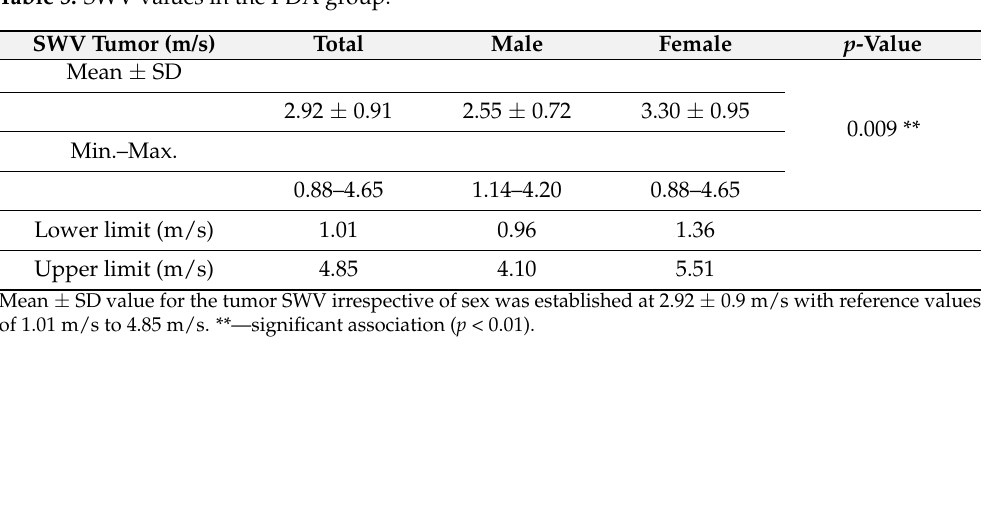
Table 5. SWV values in the PDA